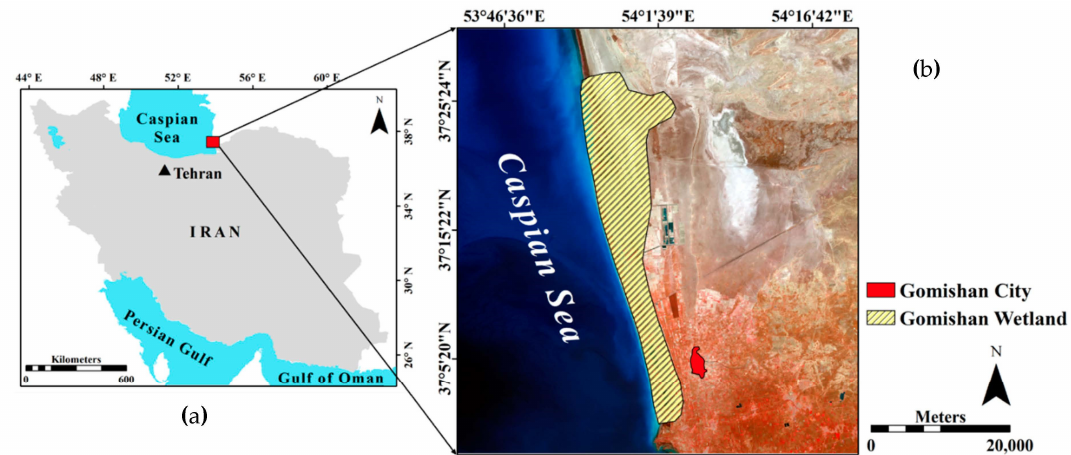
Figure 1. The study area geographical location in Iran ( a ), and the false color composite image of the Landsat 8 Operational Land Imager (OLI) (Near infrared , Red and Green bands) for 15/05/2017 of the studied area and the location of the of Gomishan wetland and city in the study area ( b ).